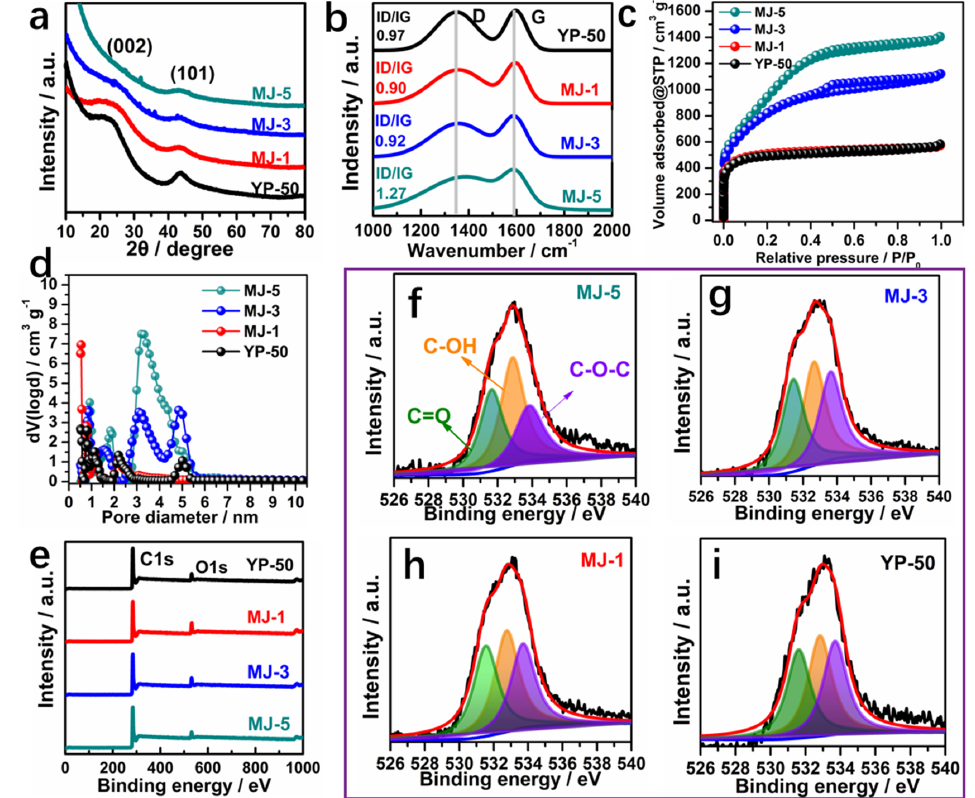
Figure 3. ( a ) Typical XRD patterns of MJ − x and YP − 50; ( b ) Roman spectra of MJ − x and YP − 50; ( c ) N 2 adsorption-desorption isotherms of MJ − x and YP − 50; ( d ) Pore size distributions of MJ − x and YP − 50; ( e ) XPS survey spectra of MJ − x and YP − 50; adsorption-desorption isotherms of MJ-x and YP-50; ( d ) Pore size distributions of MJ-x and